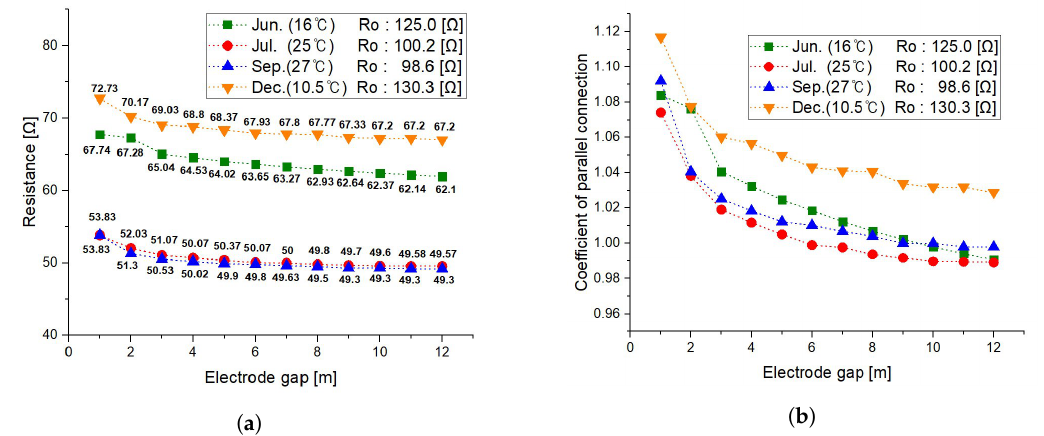
Figure 6. Variation by electrode gap: ( a ) resistance and ( b ) the coefficient of parallel connection. In this experiment, the fall-of-potential method was used to measure parallel grounding resistance, as shown in Figure 7. In Figure 7, E represents the parallel electrodes and P is the auxiliary electrode used to measure the potential difference at E. C is the auxiliary electrode used to apply a current. In this method, the potential difference between P and C is assumed to be zero by providing a sufficient distance from E. The grounding resistance could be determined by the current flowing from the power source to water and the potential difference between E and P.